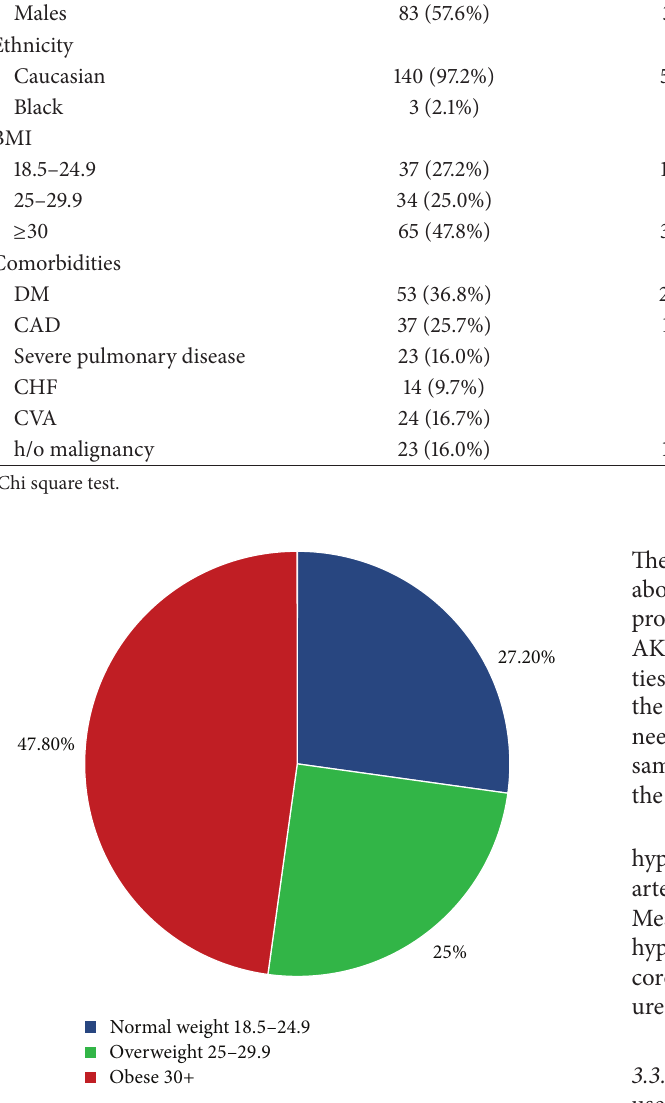
Figure 1: BMI distribution of the total patient